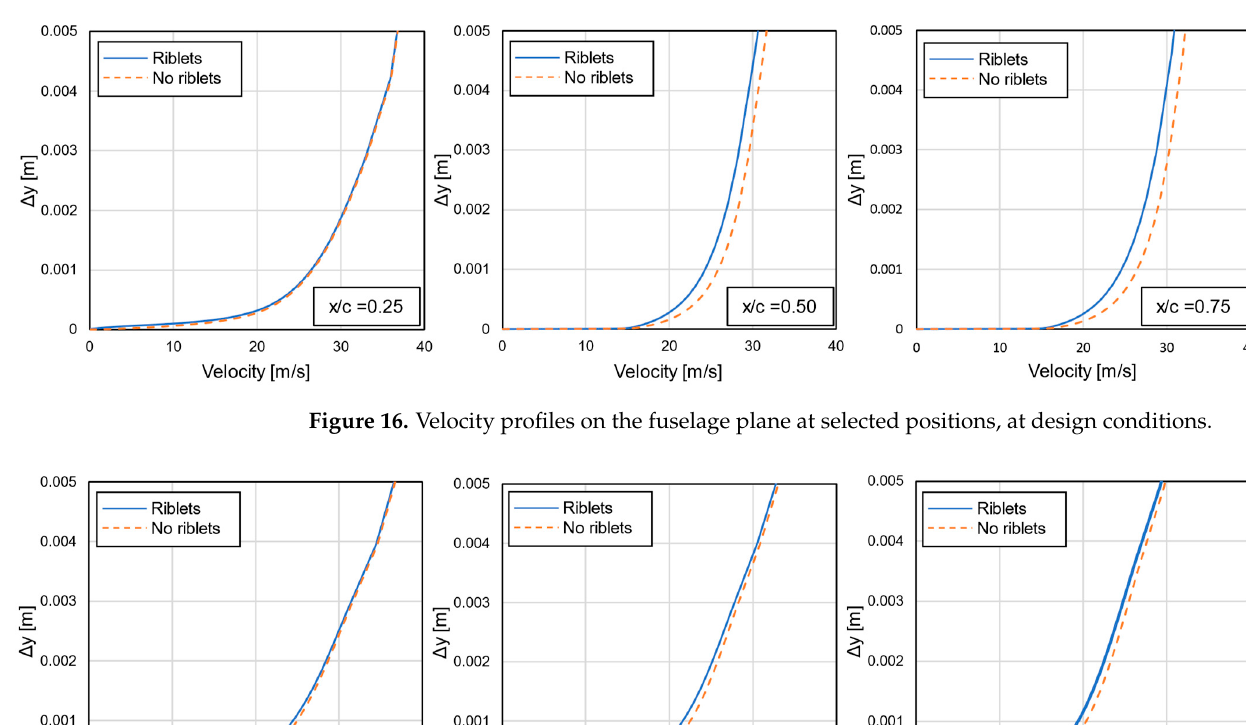
Figure 15. Velocity profiles on the MAC plane in selected positions, at design conditions.